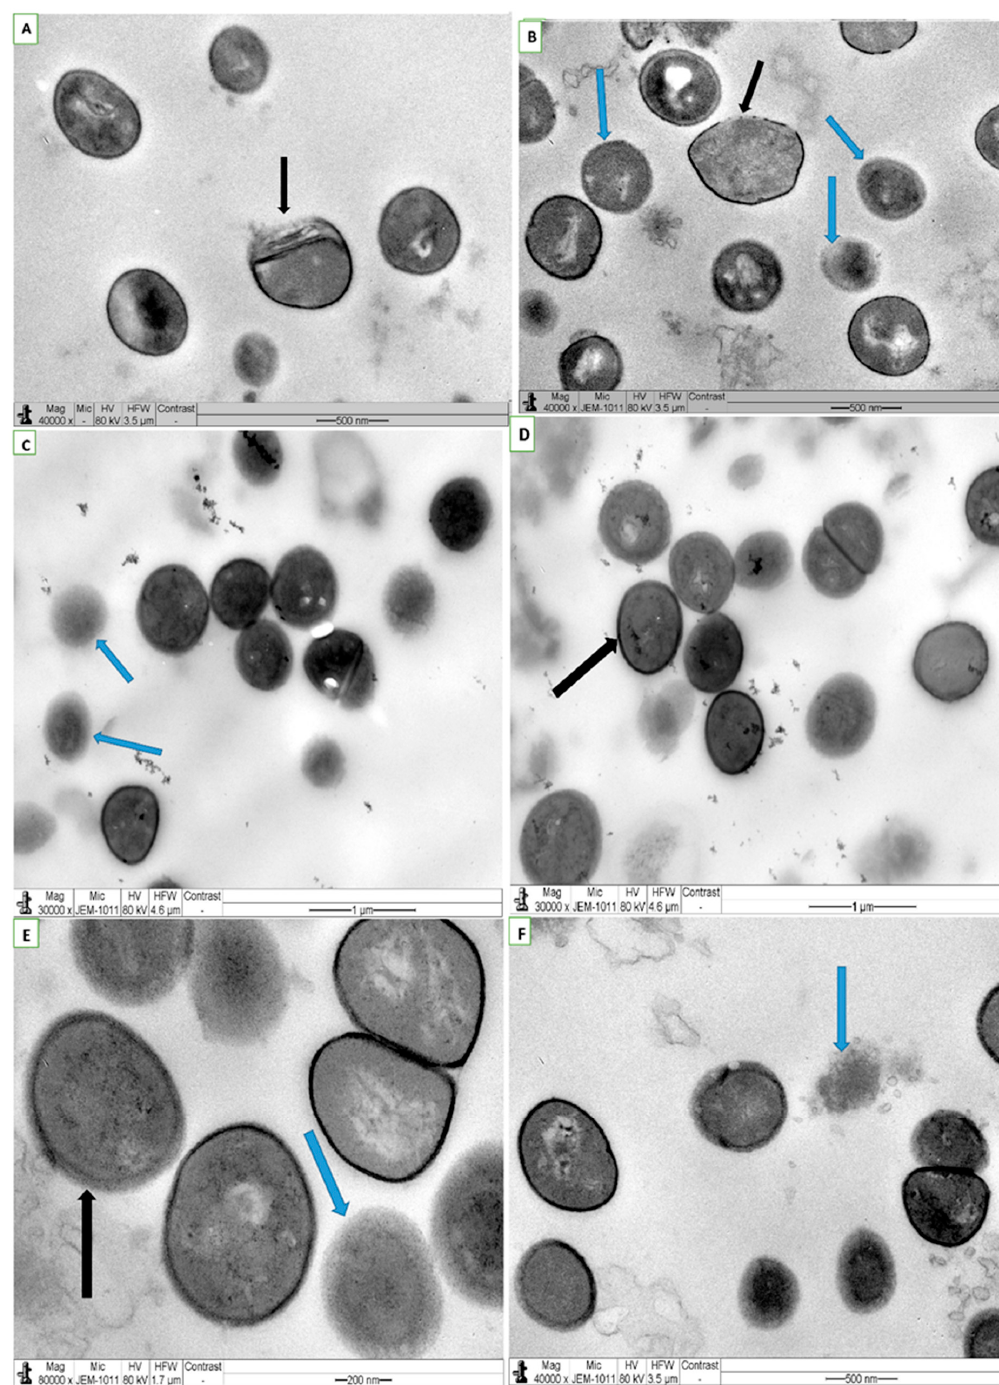
Figure 6. TEM micrographs of methicillin-resistant Staphylococcus aureus (MRSA) treated with NS and NS plus β